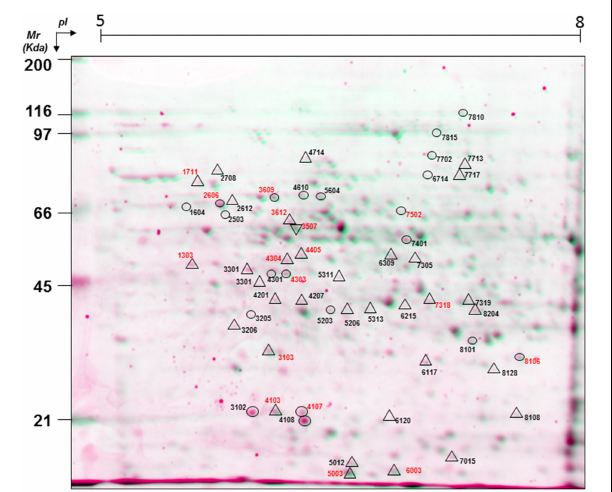
FIGURE 1 | A virtual 2-DE gel showing the protein profile of Q. ilex mature seed embryo axis (0h, un-imbibed) obtained by successive Pro-Q DPS and SYPRO-Ruby staining. Proteins stained with SYPRO-Ruby appear in green, while Pro-Q DPS stained proteins appear in red. The statistically significant differential phosphoprotein spots are indicated with circles for quantitative differences and with triangles for qualitative (absence/presence) differences. Numbers in red indicate the protein spots that were identified by MALDI TOF/TOF.